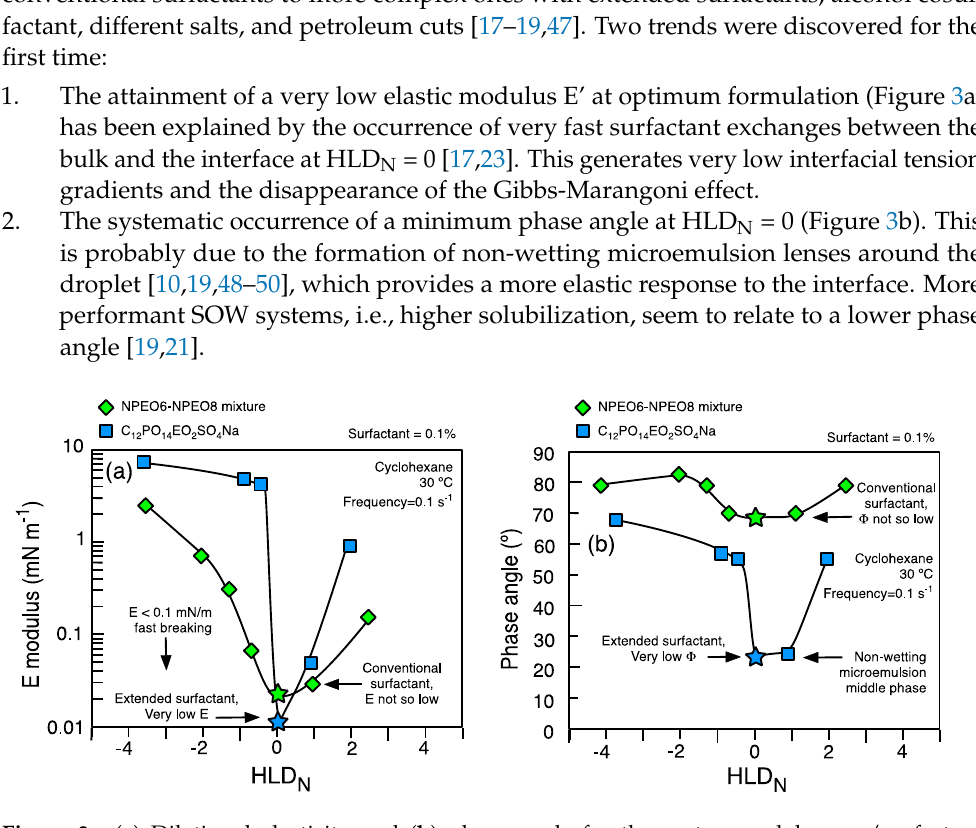
Figure 3. ( a ) Dilational elasticity and ( b ) phase angle for the system cyclohexane/surfactant 0.1%/brine. Nonionic surfactant: NEOP6-NPEO8 mixture (EON scan) and anionic extended surfac- tant: C 12 PO 14 EO 2 SO 4 Na (salinity scan) were used.